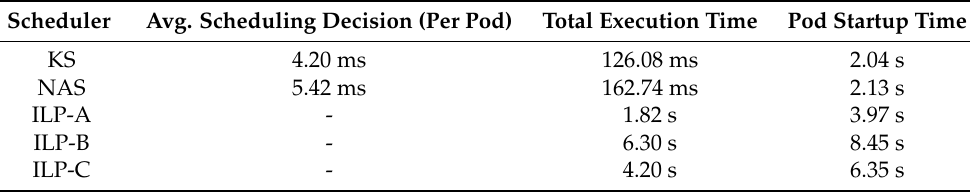
Table 6. The execution time of the different